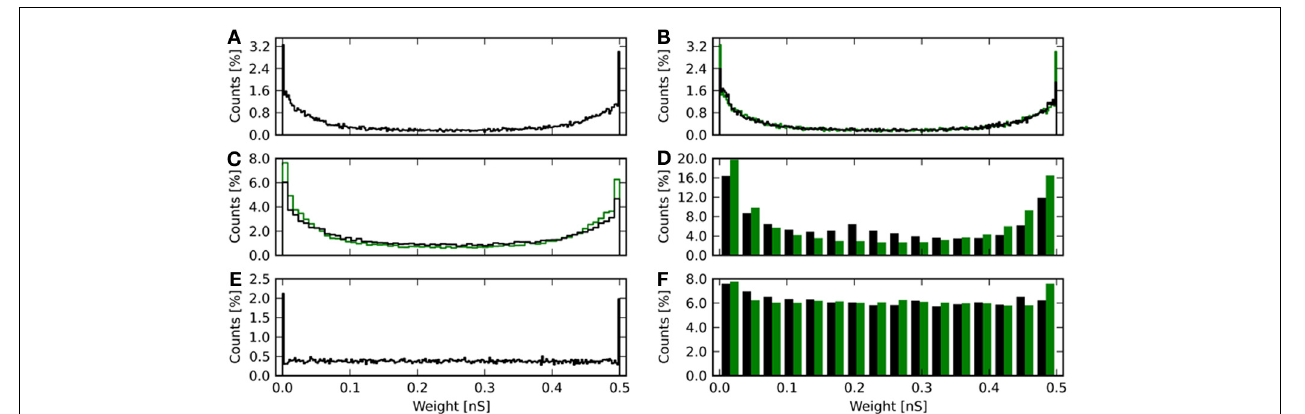
deterministic updates in black and the continuous result in green. (E) Final weights for the baseline simulation with artificially added noise, of which the reward trace is shown in Figure 6 . (F) Final weight histogram for 4bit resolution with probabilistic updates in black. Now the green bars give the distribution of weights from the baseline simulation with added